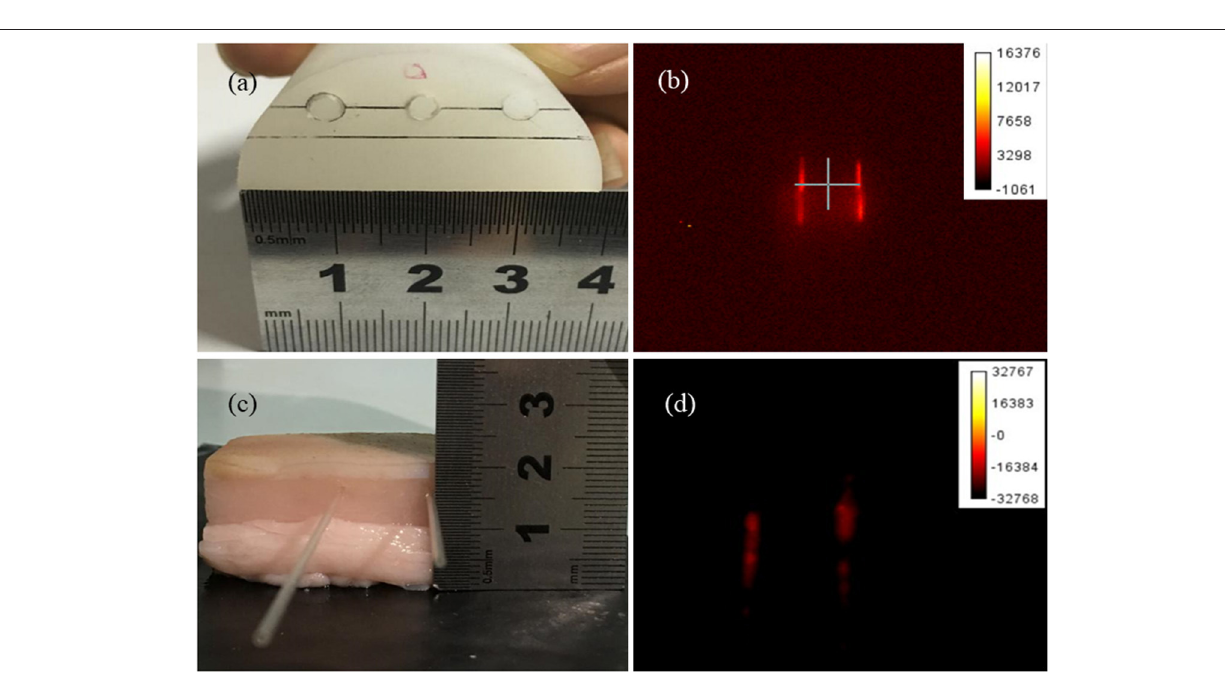
Frontiers in Physics |